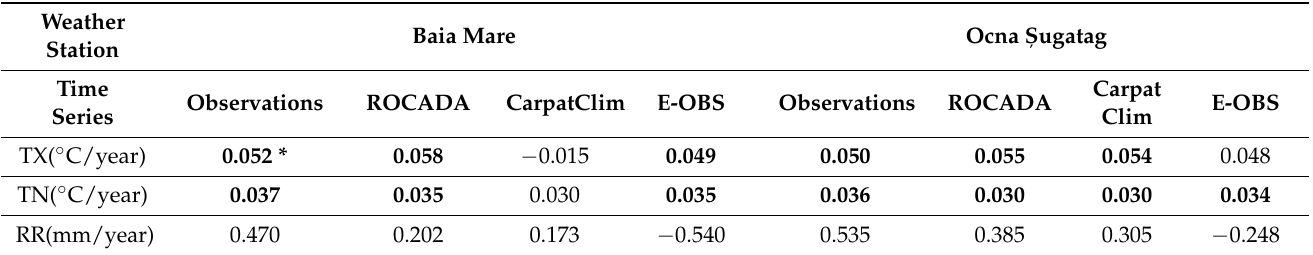
ugatag weather stations. , ,